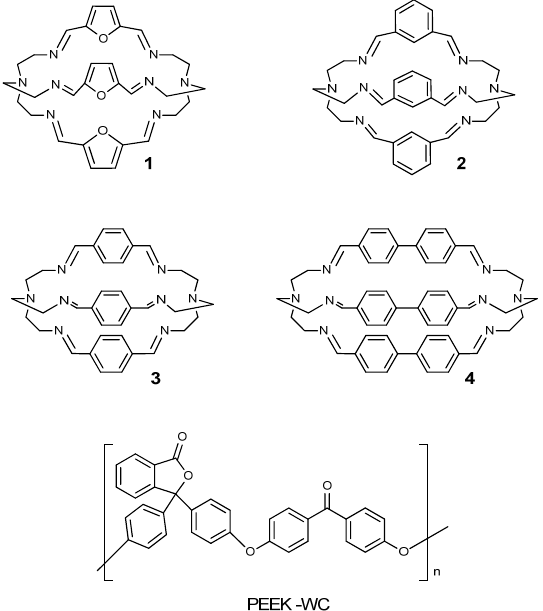
Figure 1. Structure of the cages ( 1 = furanyl, 2 = m -xylyl, 3 = p -xylyl, 4 = diphenyl) and the polymer PEEK-WC used in the present work.